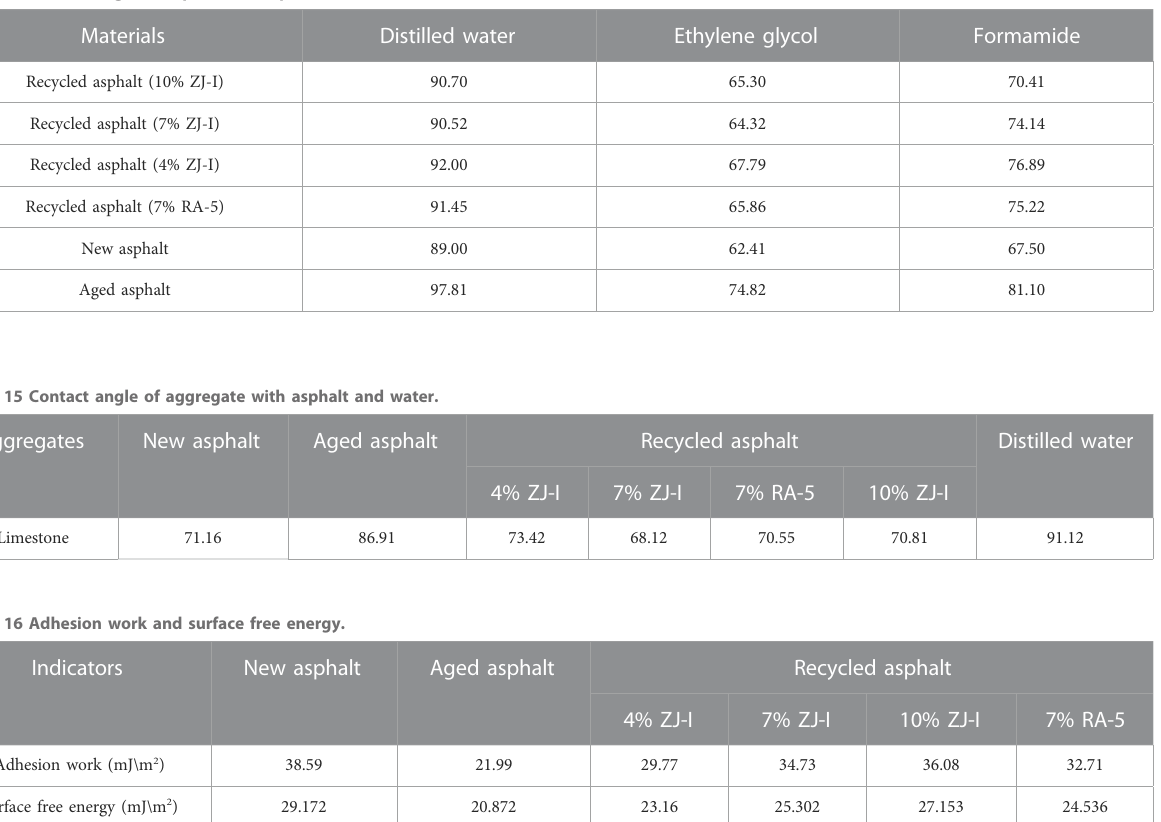
TABLE 14 Contact angle of asphalt and